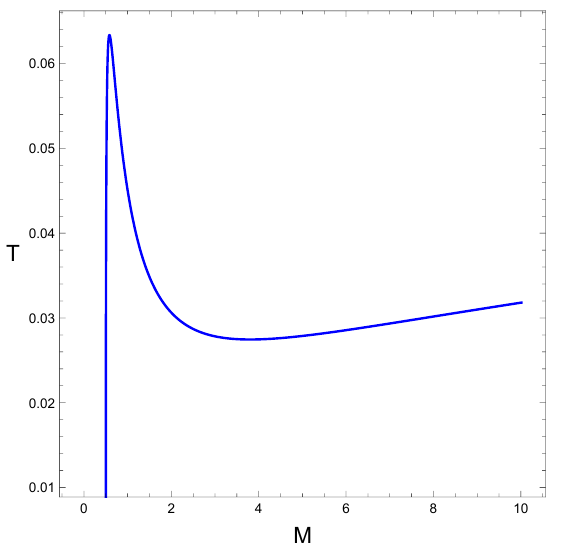
Figure 8 . T versus M . T is plotted against M in d = 4, with l = 10 and Q = 0 : 5 = 0 : 3 Q c . We see the oscillatory behaviour of T ; our T / S E and T /(cid:1) L graphs (Figs 4 and 5) are just rescaled versions of this